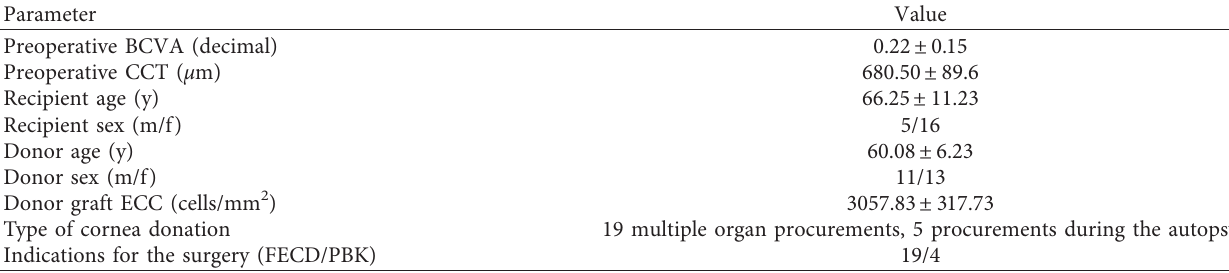
Table 1: Preoperative characteristics of the patient and donor corneas.